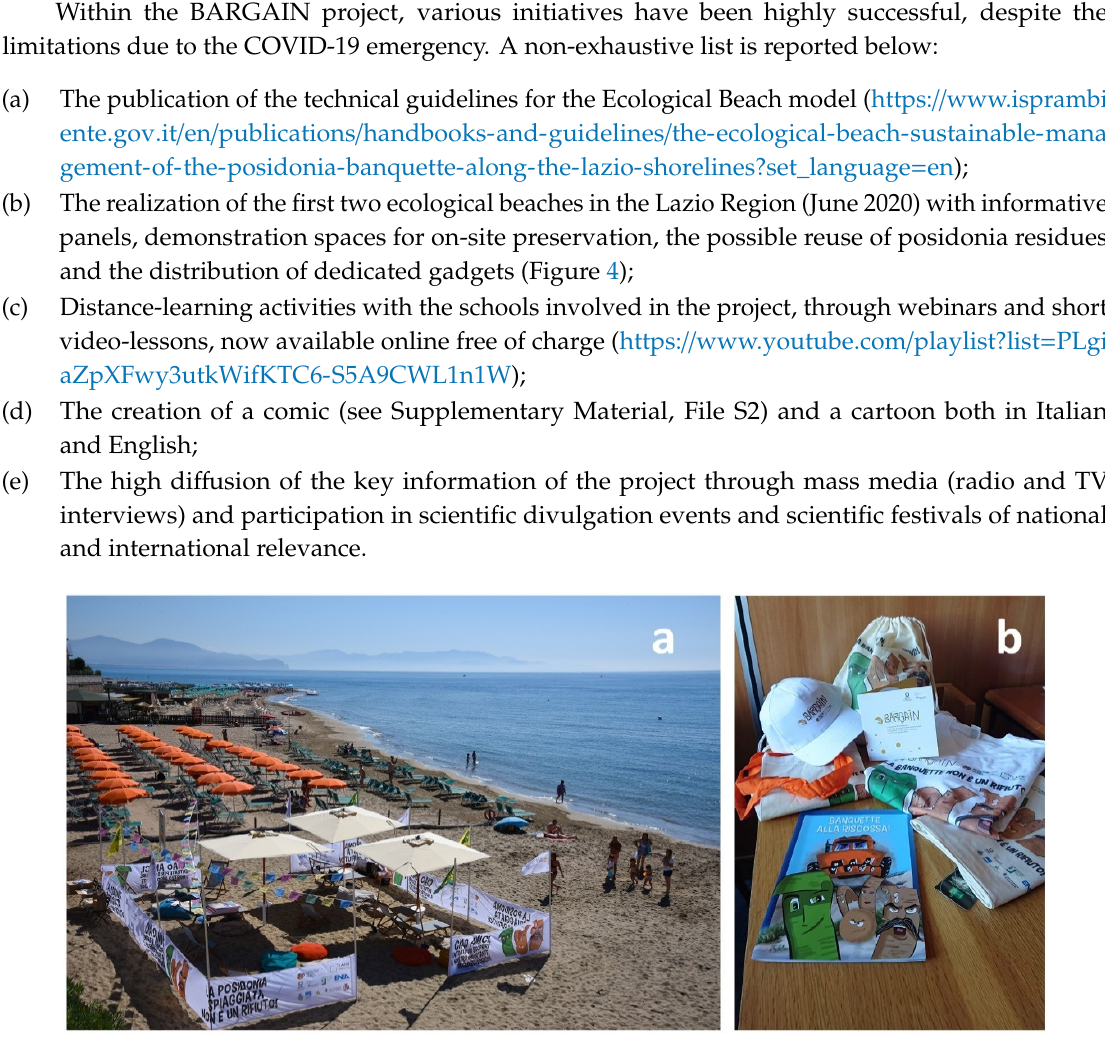
Figure 4. The realization of the Ecological Beach model within the BARGAIN project. ( a ) Demonstration space at Circeo National Park beach. ( b ) Gadgets and comics distributed to beach visitors.